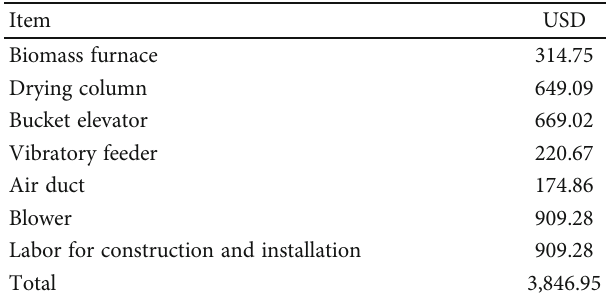
Table 4: Investment cost of the